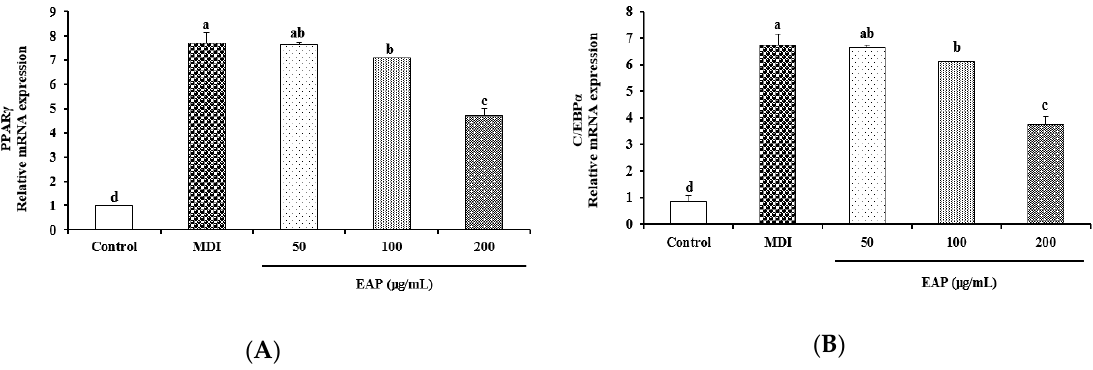
Figure 4. Effects of EAP on mRNA expression of PPAR γ ( A ) and C/EBP α ( B ) in 3T3-L1 adipocytes. EAP: Erigeron annuus (L.) Pers. water extract, 3T3-L1 preadipocytes were differentiated in the presence of EAP at different concentrations (50 to 200 μ g/mL) for seven days. The mRNA expression level was measured by real time-PCR and normalized using housekeeping gene GAPDH. Values are presented as mean ± standard deviation. Differences between means were considered statistically significant at P < 0.05.